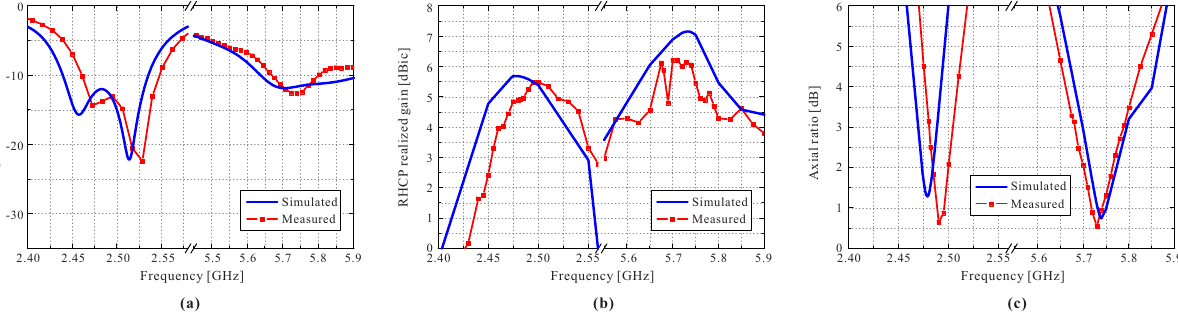
Figure 13. Simulated and measured results of the dual-band patch antenna: ( a ) reflection coefficients; ( b ) realized gain; ( c ) axial